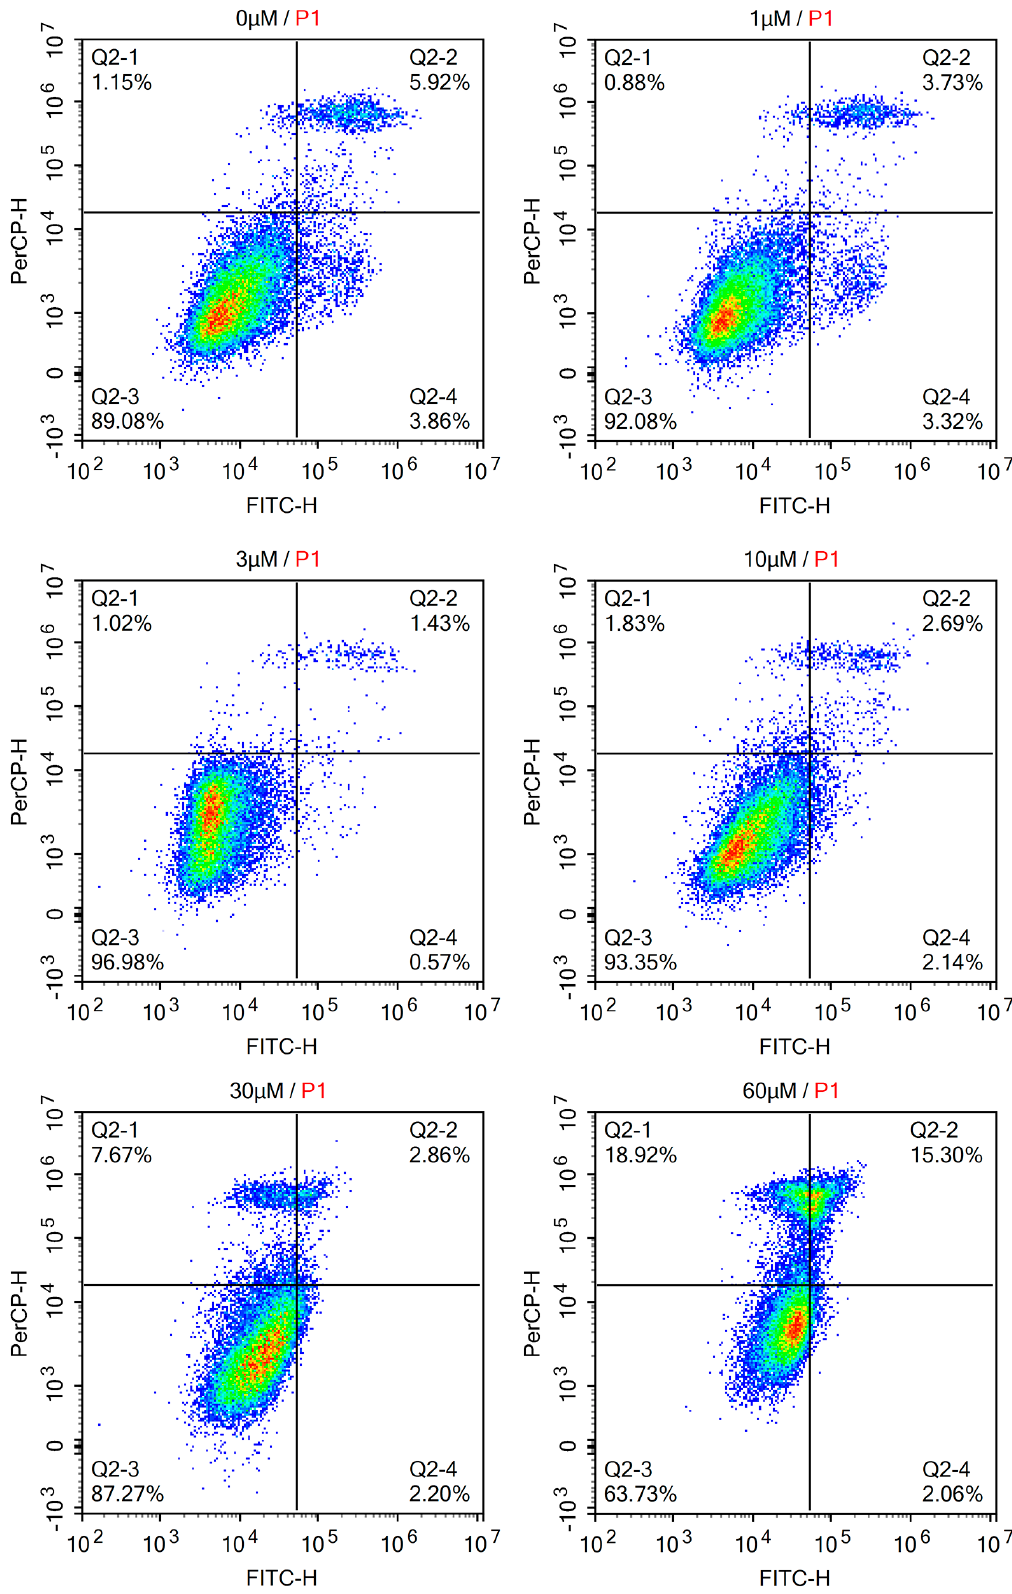
Figure 4. Pro-apoptotic effect of PYR26 on HepG2 cells confirmed by Annexin VFITC/PI. Q2-1 shown necrotic cells, Q2-2 shown late apoptotic cells, Q2-3 shown normal cells, and Q2-4 shown early apoptotic cells.